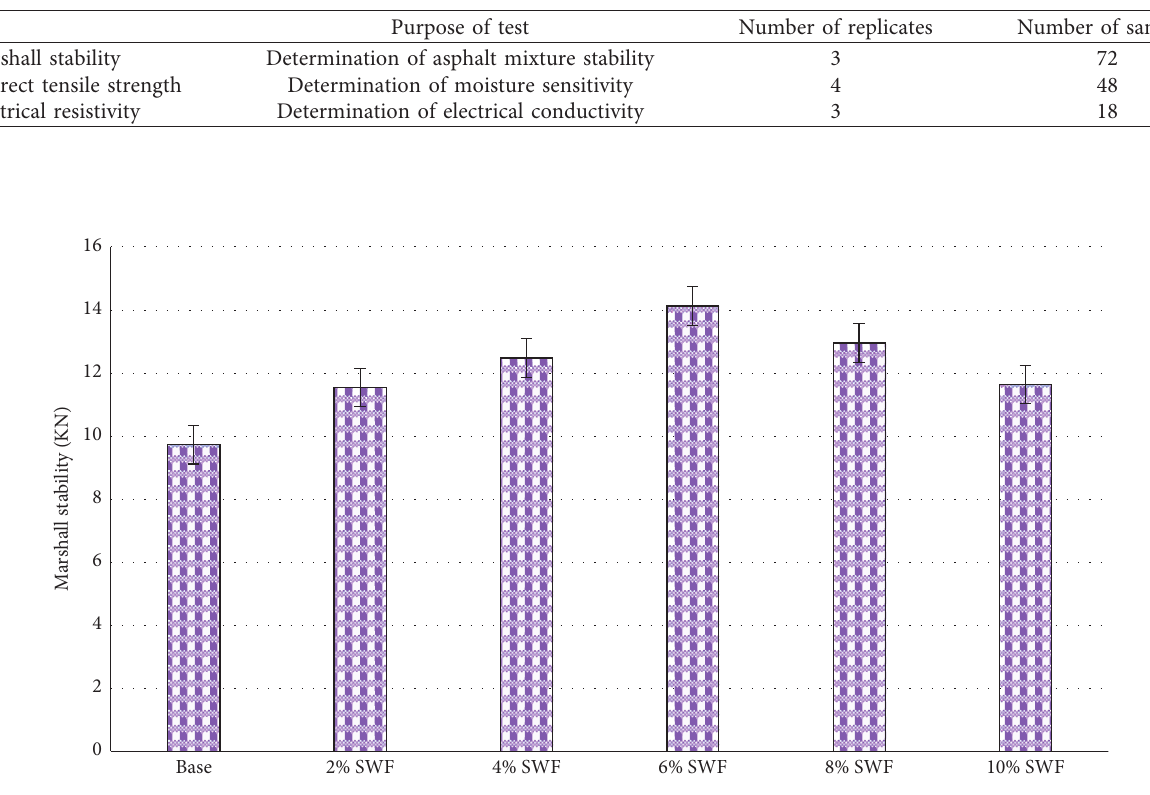
Figure 3: The Marshall stability results of unmodified and modified asphalt mixtures.